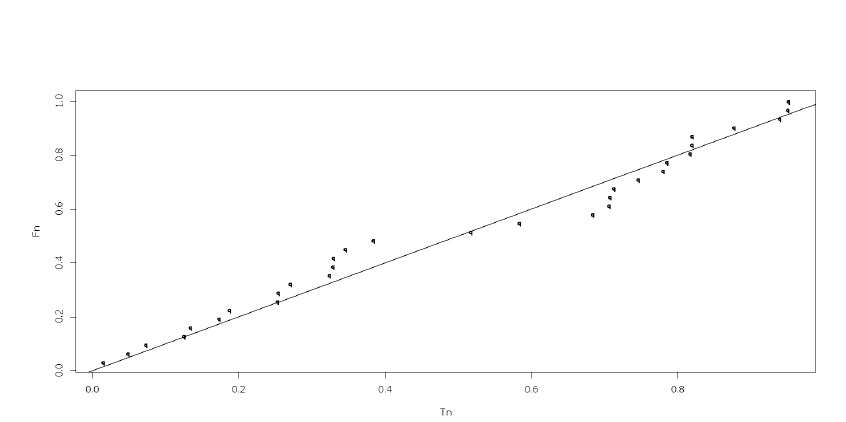
Figure 7 – PP plot for glass airplane window data.